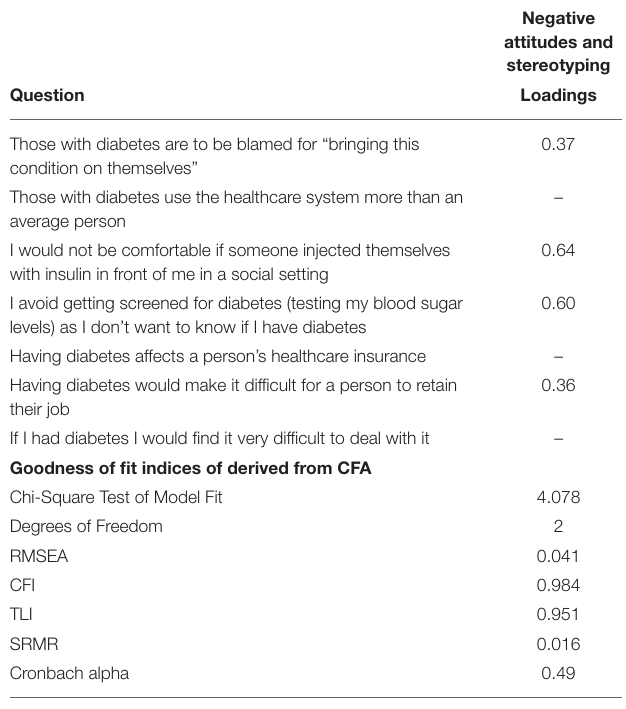
TABLE 3A | Factor loadings and goodness-of-fit indices of the final model of the social distance scale.